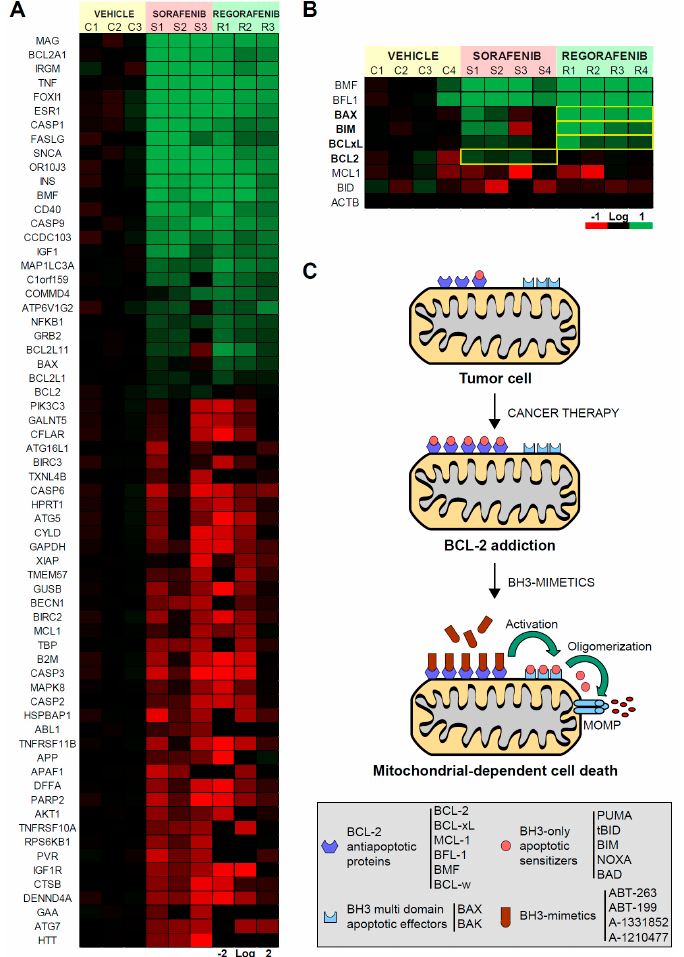
Figure 1. Sorafenib and regorafenib regulate the BCL-2 profile differently, sharing mitochondrial dependence but a distinctive therapeutic approach. ( A ) Transcriptomic analysis of genes related with liver cancer in BCLC9 tumors from nude mice treated for three weeks with vehicle (C1-3), sorafenib (S1-3), or regorafenib (R1-3). ( B ) mRNA expression of different BCL-2 proteins from treated tumors (C1-4, S1-4, and R1-4). Differences in the mRNA pattern are highlighted with yellow squares. ( C ) Cancer therapy may increase anti-apoptotic BCL-2 proteins avoiding cell death but mito-priming the cells to BH3-mimetics. Resistant hepatoma cells treated with compounds targeting BCL-2 proteins may release BH3-only proteins to bind BAX / BAK and trigger apoptotic cell